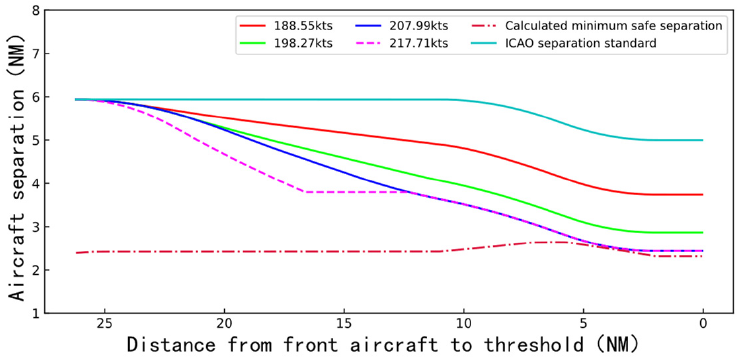
Figure 8. Dynamic separation change when CRJ-900 follows a heavy aircraft.